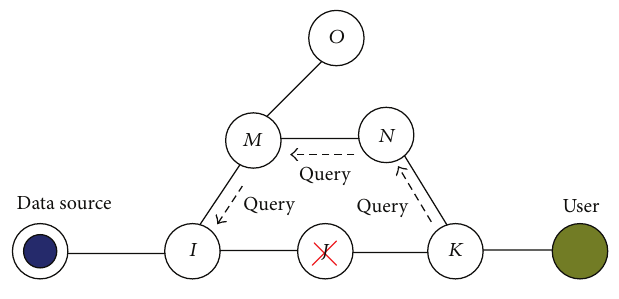
Figure 7: Solution for recovery of the return path.